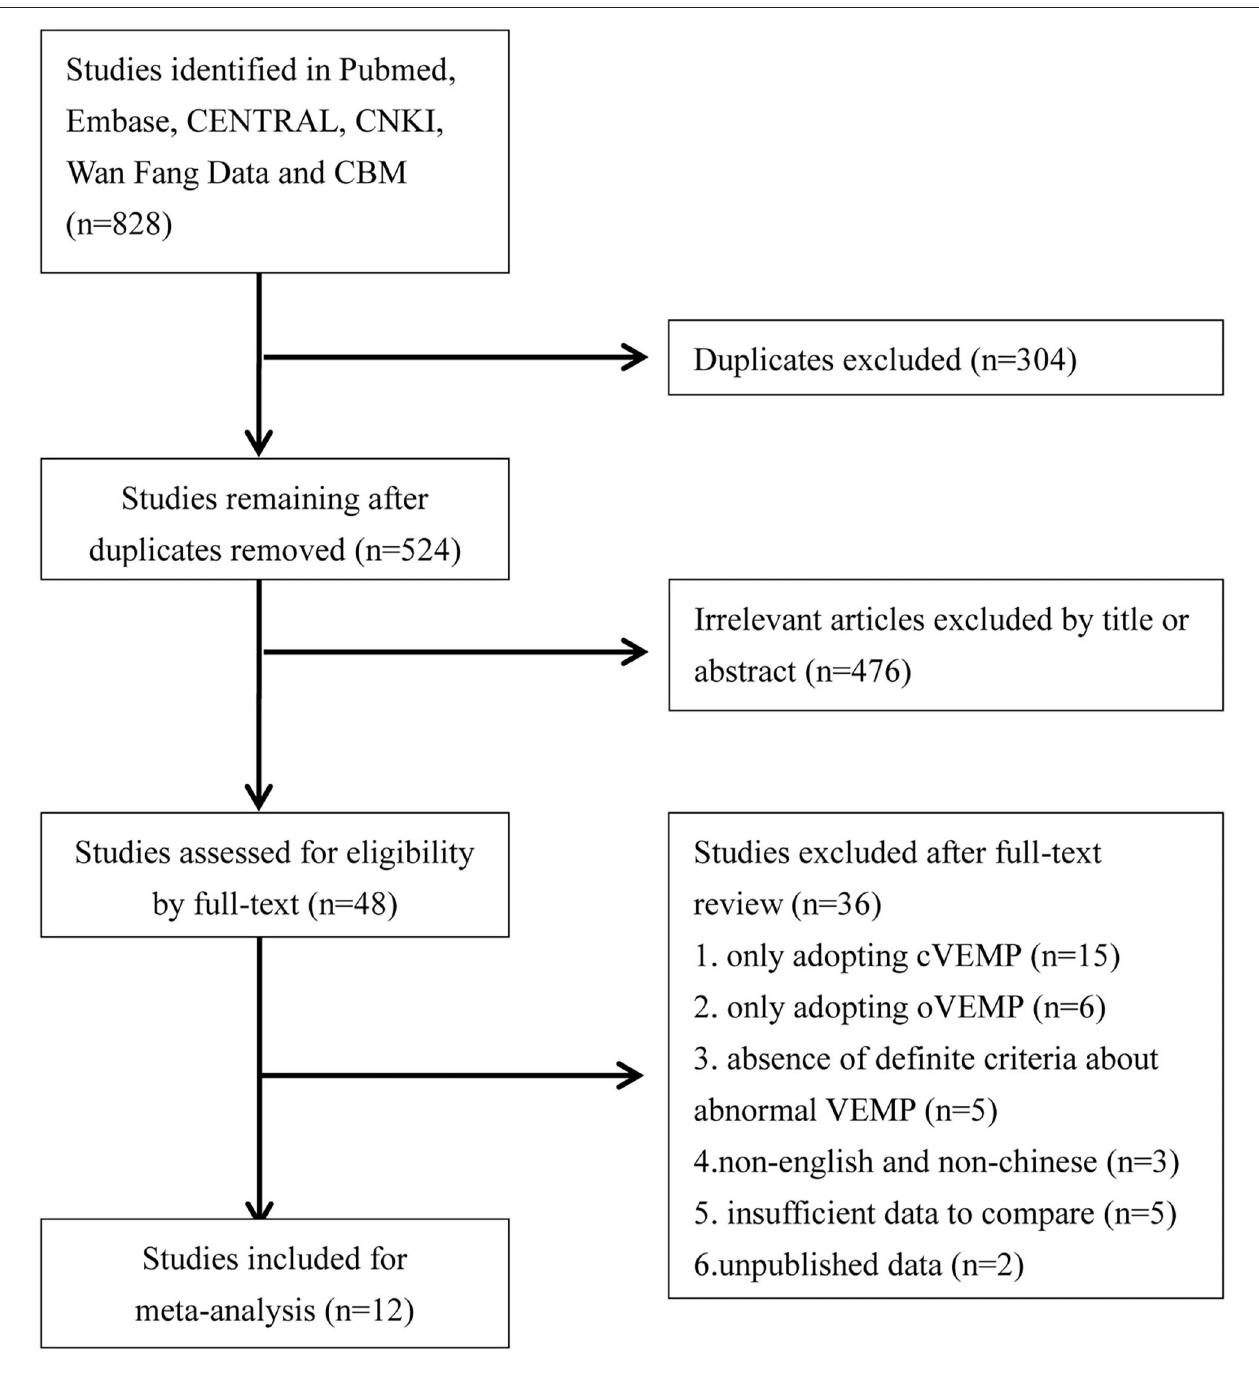
FIGURE 1 | Flowchart of data search and studies selection for